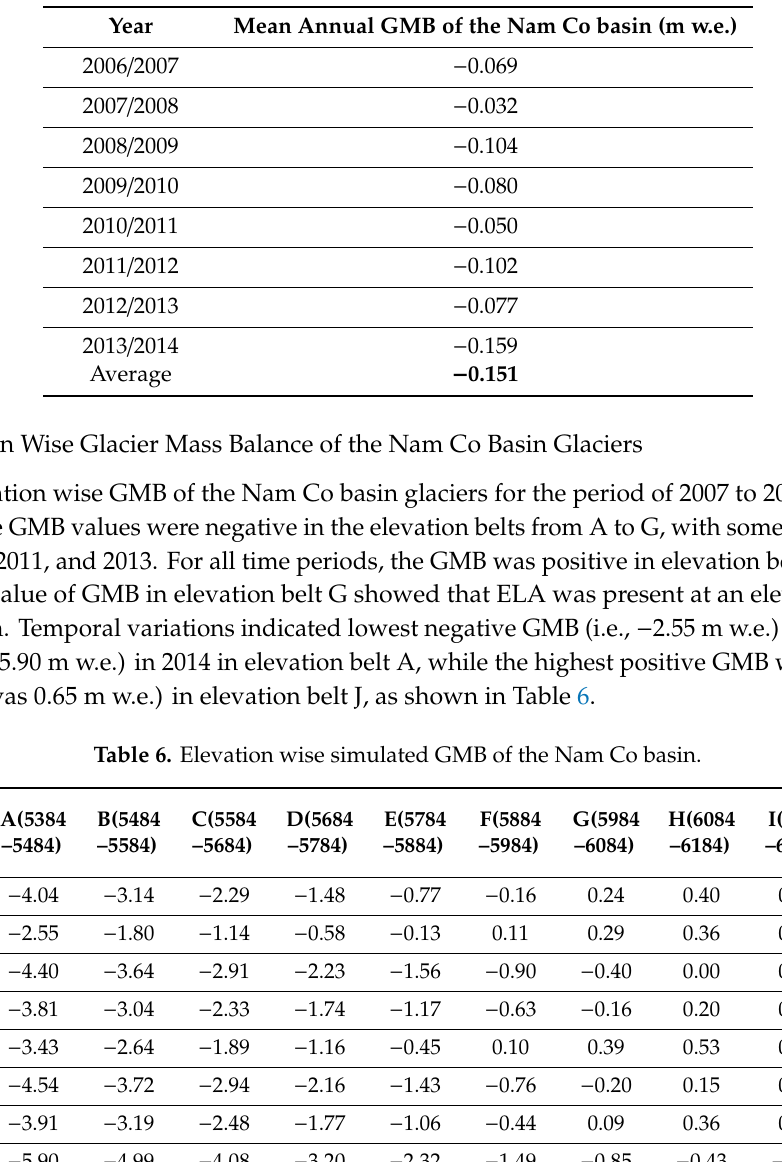
Table 5. Mean annual GMB of the Nam Co basin.